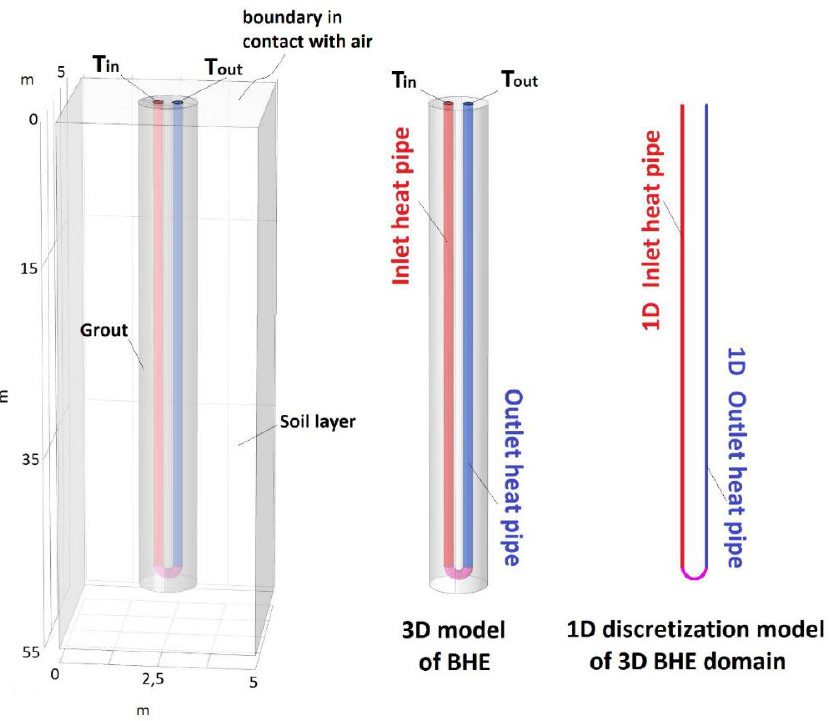
Figure 3. Computational domains for the borehole heat exchanger.